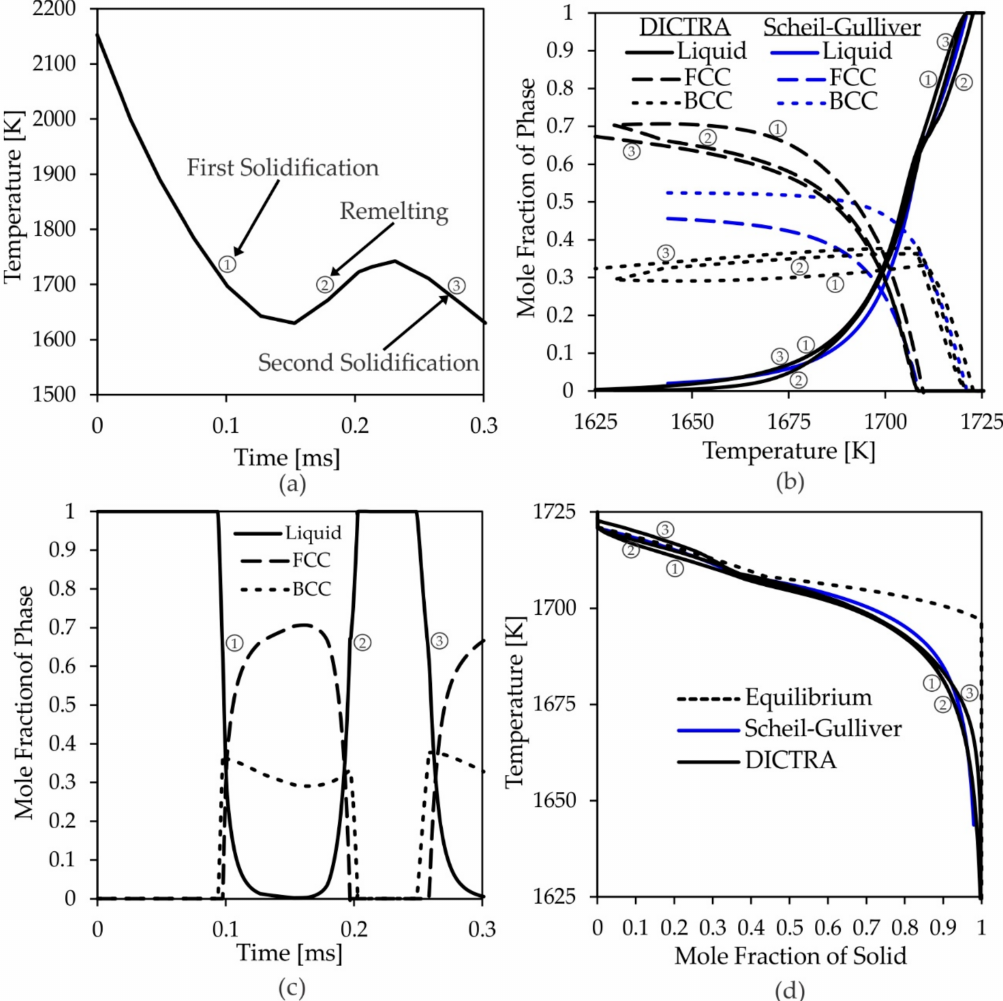
Figure 5. Non-equilibrium solidification modeling of stainless steel 316L undergoing rapid double melting. (1) corresponds to the first solidification transformation, (2) refers to remelting, and (3) marks the second solidification transformation. ( a ) Temperature history with rapid double melting directly used as an input to the diffusion-controlled transformations (DICTRA) model. ( b ) Mole fraction of each phase as a function of temperature predicted using the DICTRA and Scheil- Gulliver models. ( c ) Mole fraction of each phase as a function of time modeled using DICTRA. ( d ) Temperature versus the mole fraction of solid as predicted by the equilibrium, Scheil-Gulliver, and DICTRA models for